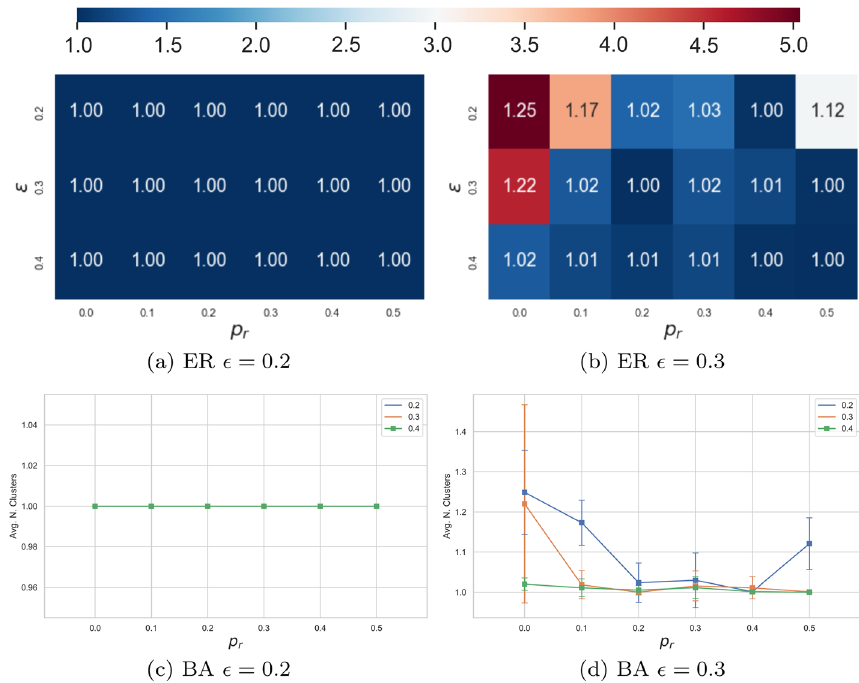
Fig. 8 Average number of clusters in the steady-state for the Adaptive Deffuant–Weisbuch bounded confidence model on Simplicial Complexess. The average number of clusters in the final state for the Adaptive Deffuant–Weisbuch bounded confidence model on Simplicial Complexes fixing γ = 0.0 , as a function of ǫ and p r for a , b a Erdős–Rényi graph and c , d a scale-free Barabási–Albert graph. These values are averaged over 30